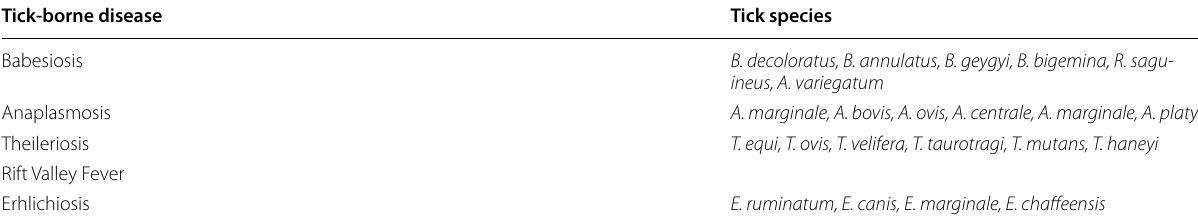
Table 2: Shows the tick-borne diseases and tick species identified Tick‑borne disease Tick